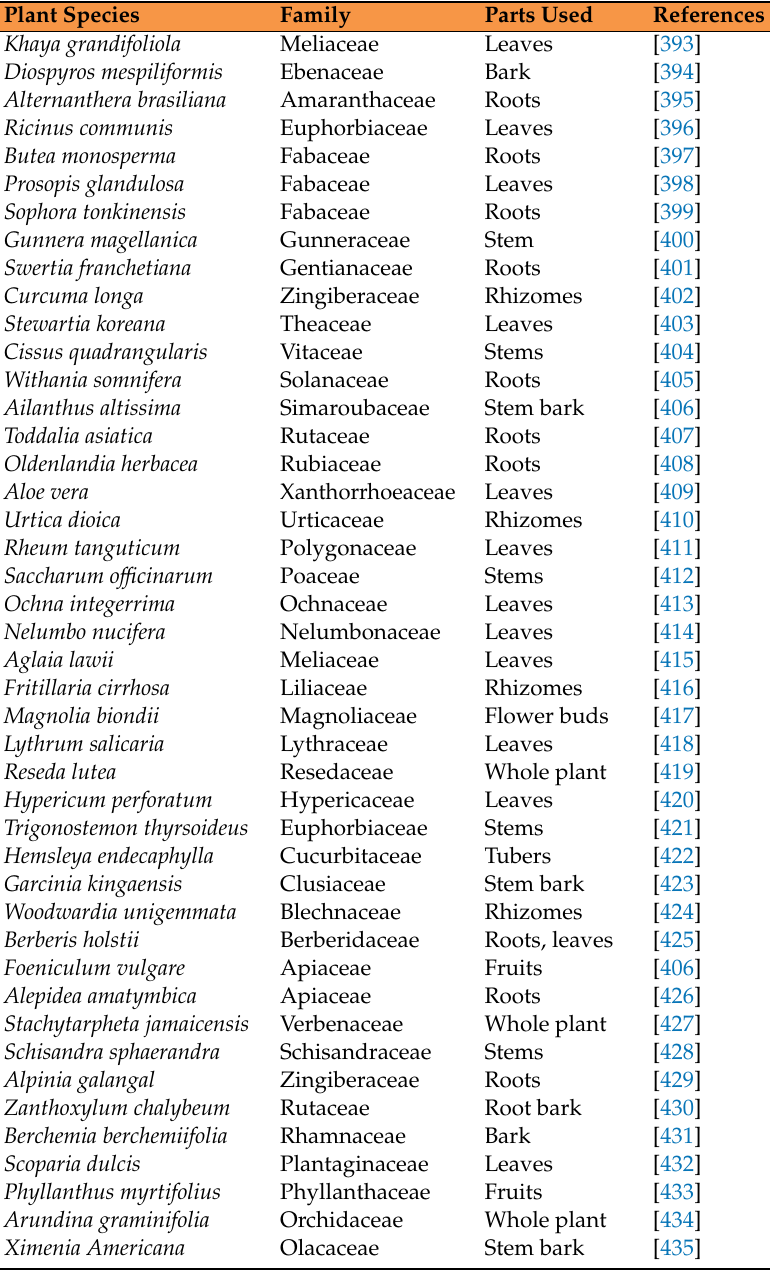
Table 5. Assortments of other plant species have been given in Table